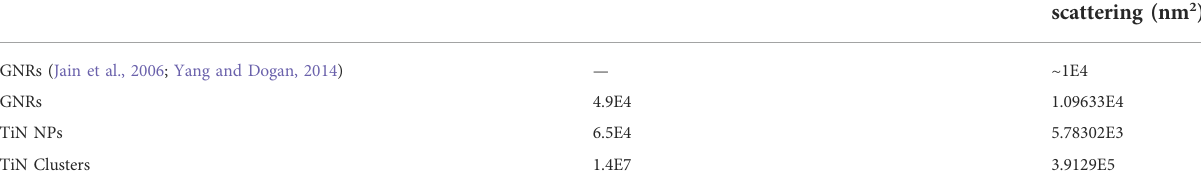
TABLE 1 Particle volume and scattering cross-section values for all nanomaterials compared to